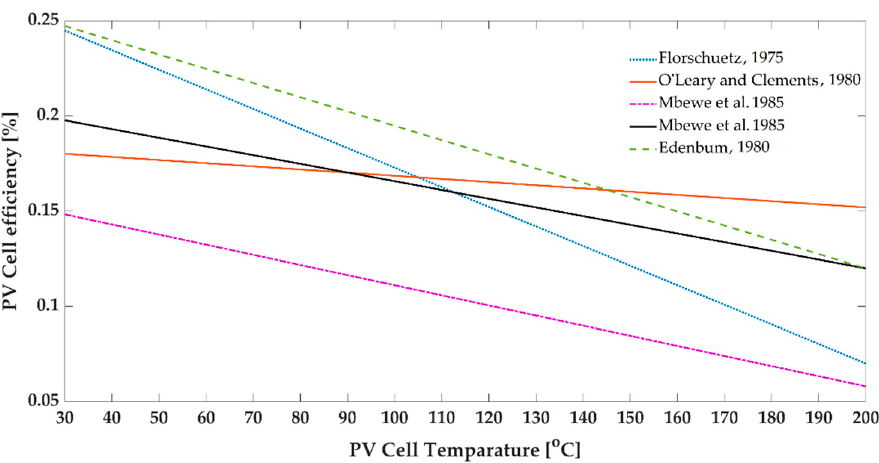
Figure 7. PV cell efficiency vs. PV cell operating temperature with specified conditions from [3,31].